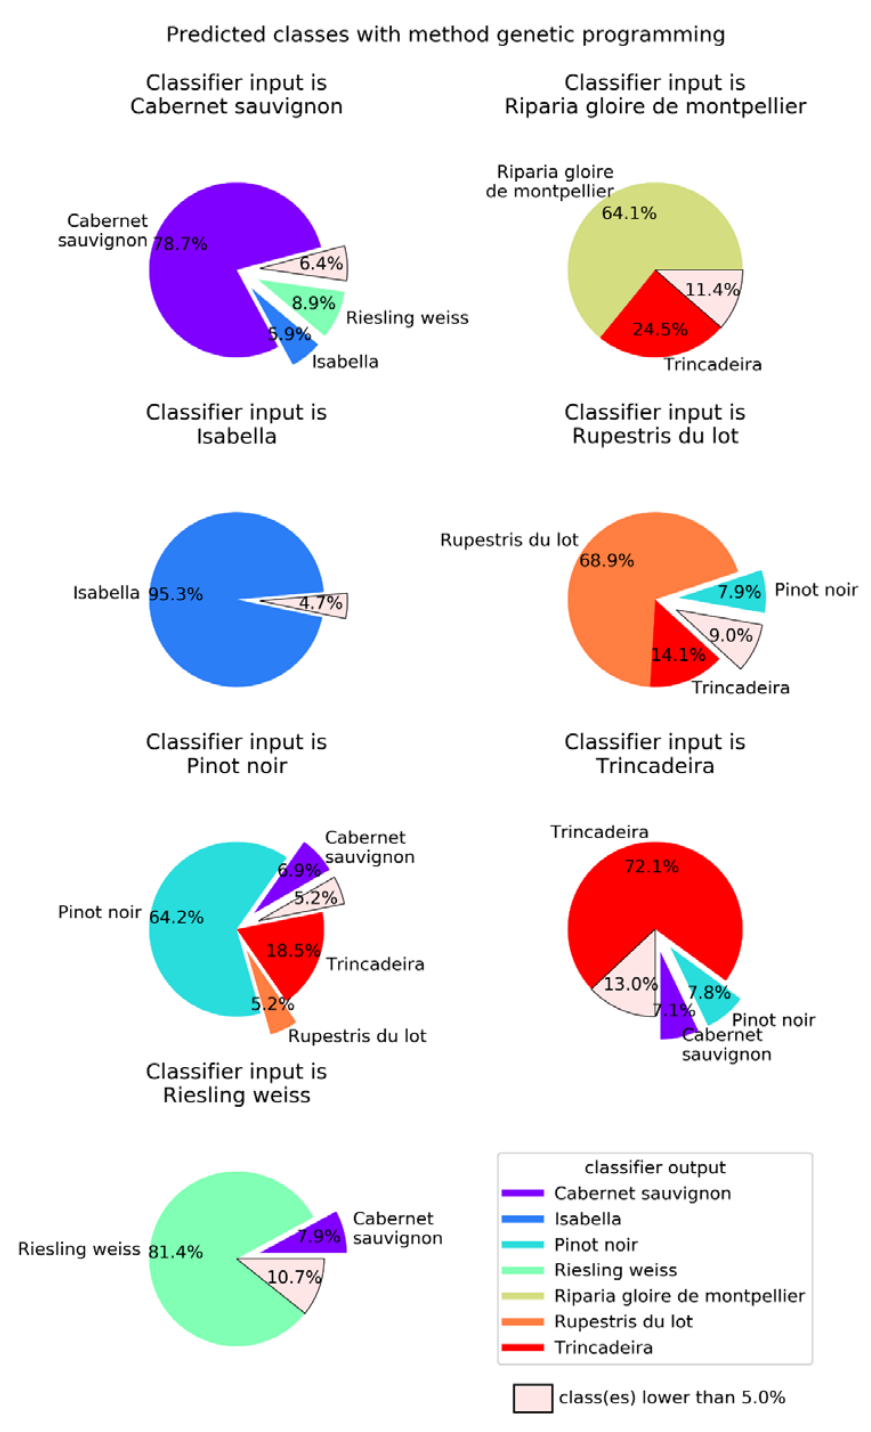
Figure 7. Genetic programming (GP) classifier output for each of the seven possible inputs. Results were obtained using a population of 250 individuals allowed to evolve for at most 100 generations. Global success rate is 75.3%.